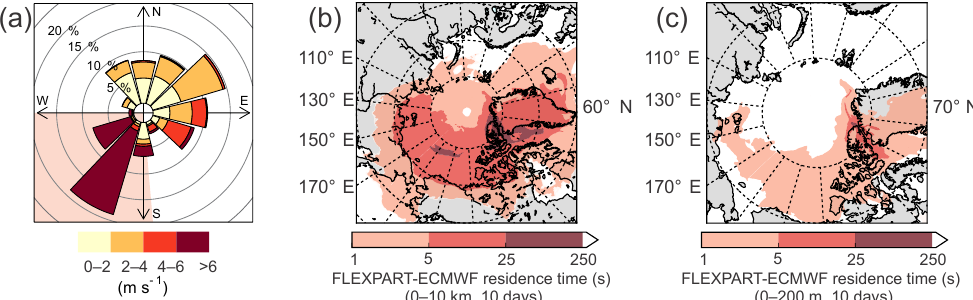
Figure 2. (a) Wind rose for the entire campaign. The shaded area shows the high wind speed regime (see text). (b) FLEXPART-ECMWF summed over the entire column (0–10km), averaged over the entire campaign, and integrated 10 days back in time. That the darker colors are mostly restricted to the Arctic indicates that the air arriving at Alert had mostly spent at least the last 10 days within the Arctic circle. (c) FLEXPART-ECMWF summed over the lowest 200m, averaged over the entire campaign, and integrated 10 days back in